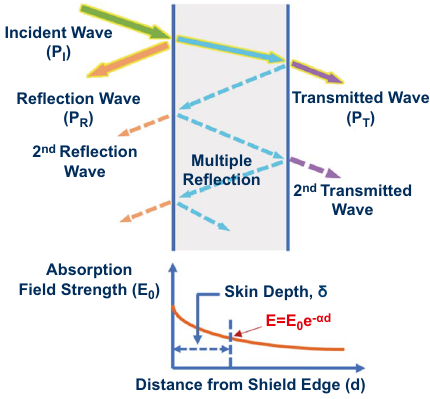
Fig. 1 EMW propagation model in EMI shielding